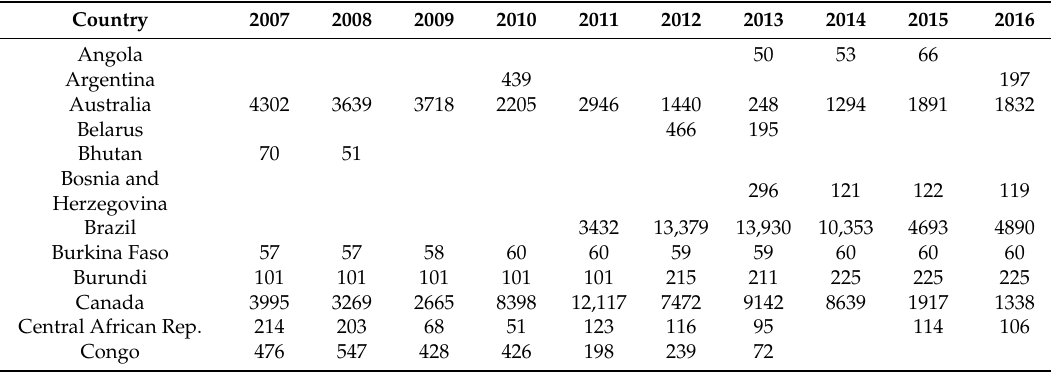
Table 8. Surplus of industrial roundwood supply (harvests + net imports), if the forest industry production data are correct. Results from the LP test. Only countries where the surplus is more than 50,000 m 3 in any of the years 2007–2016 are listed. Entries less than 50,000 m 3 are not